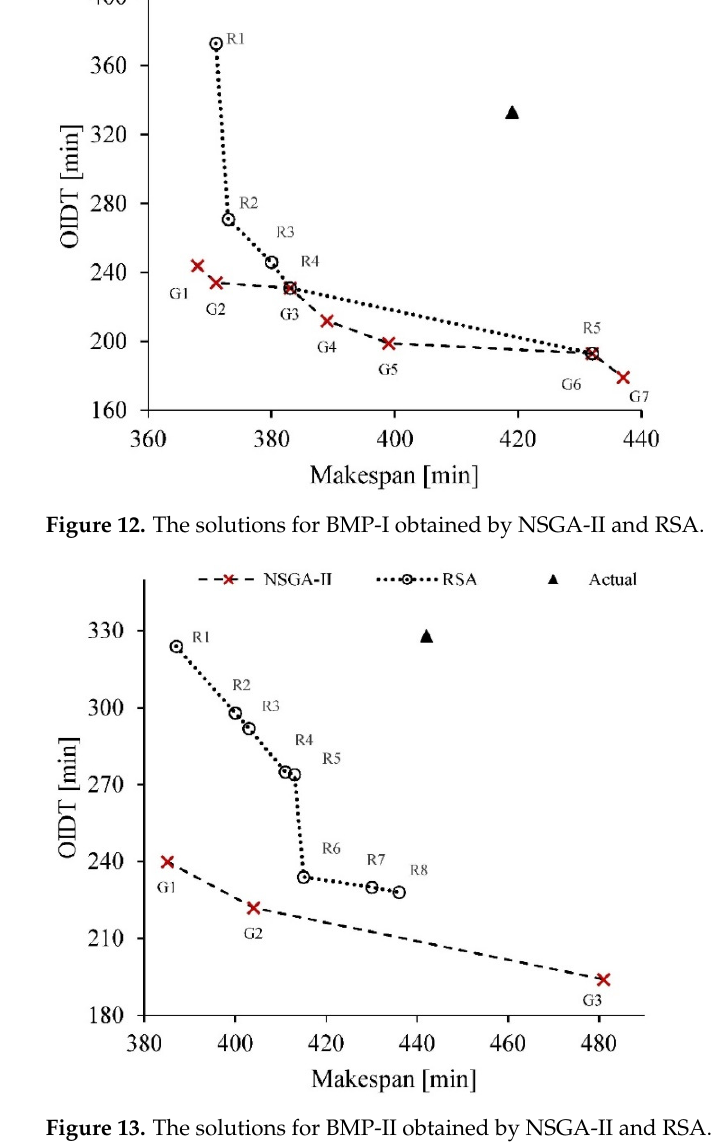
Figure 13. The solutions for BMP-II obtained by NSGA-II and RSA.